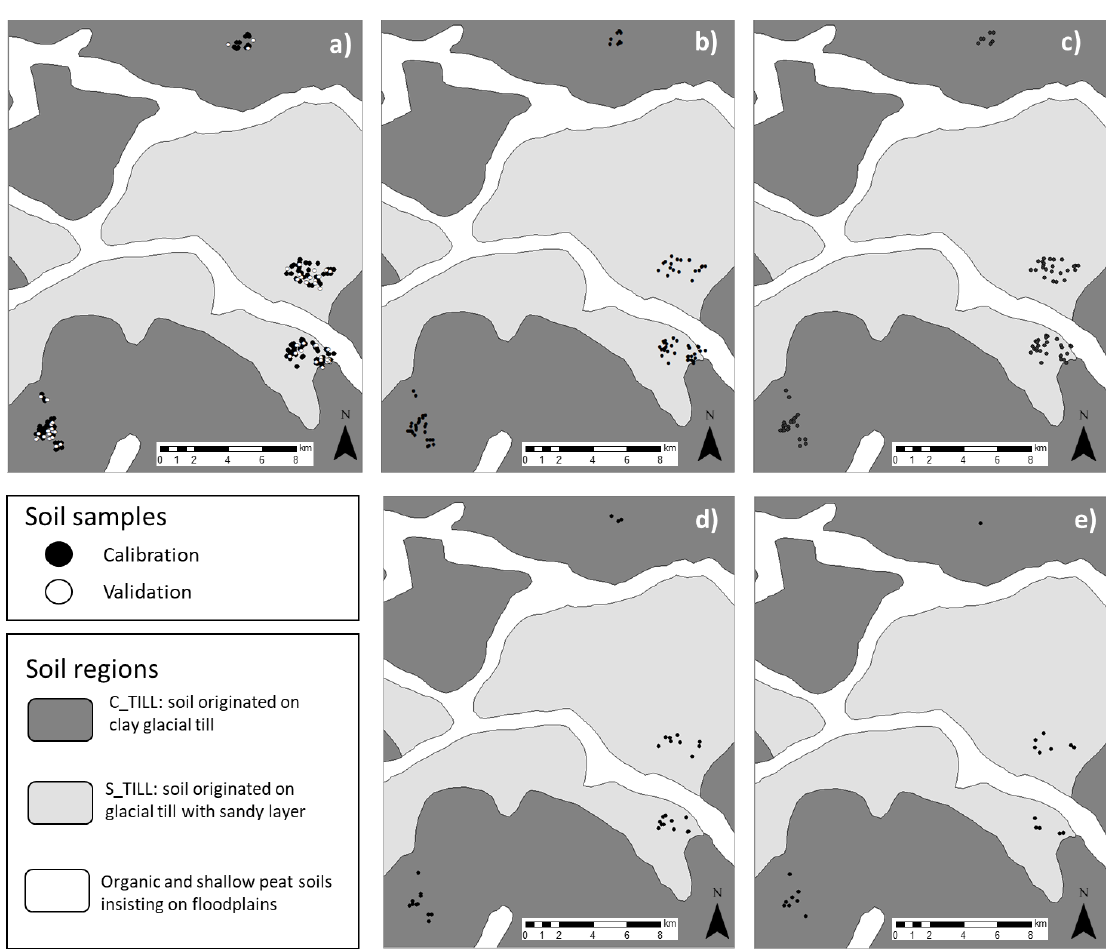
Figure 10. Location of the samples of the MWP dataset ( a ) and those of the calibration dataset detected by the cLHS ( b ), Kennard – Stones ( c ), Puchwein ( d ) and SELECT ( e ) algorithms.